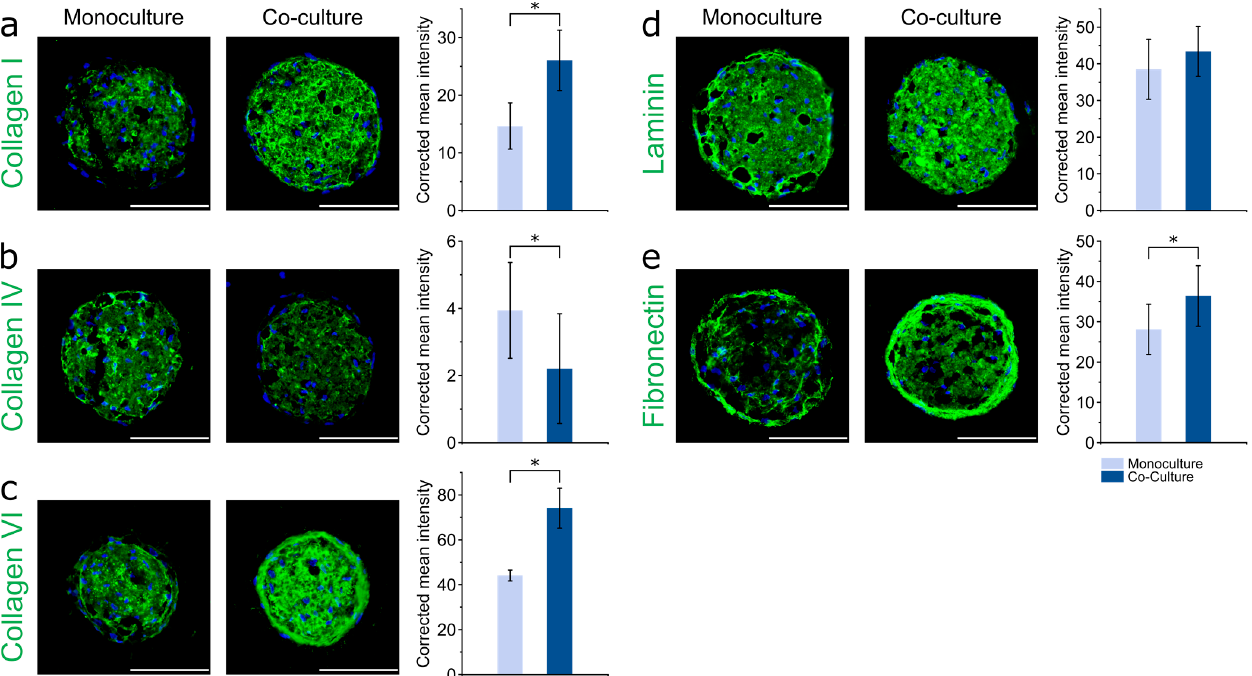
Figure 7. ECM deposition in adipose spheroids within the printed 3D co-culture model. ASC spheroids were printed in HA-SH/P(AGE-co-G) hydrogels, followed by adipogenic differentiation for 21 days. Subsequently, MDA-MB-231 cells were printed on the adipose constructs using the same gel formulation, and co-culture was performed for 9 days. Immunofluorescence staining of ( a ) collagen I, ( b ) collagen IV, ( c ) collagen VI, ( d ) laminin and ( e ) fibronectin, and quantification of the respective fluorescence intensities. Nuclei were counterstained with DAPI (blue). ASC spheroids in monoculture and co-culture on day 9 of the experiment are compared. Representative images are shown. Scale bars represent 100 µm. Data are presented as mean ± standard deviation ( n = 10). Statistically significant differences are indicated by * ( p < 0.05).